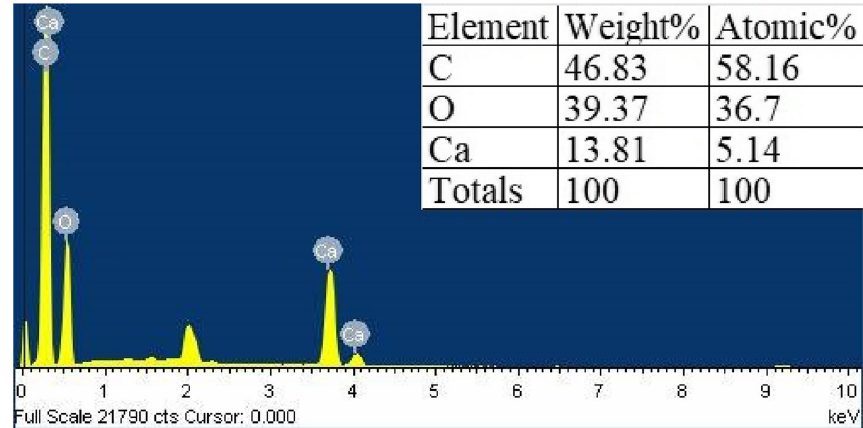
Fig. 4 Energy dispersive (EDX) of CaCO 3 NPs